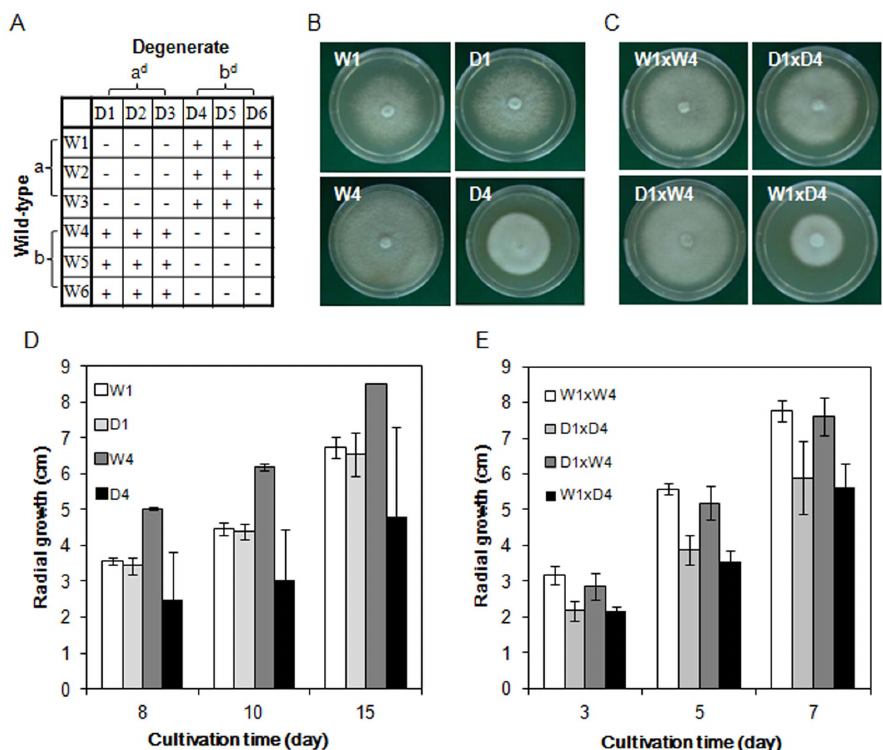
Figure 2. Growth of monokaryotic mycelia and test crosses in F.velutipes . (A) Crossing table of the monokaryons derived from the wild-type or degenerate strains. (B) Morphology of the mycelia of the degenerate monokaryons (right) and their wild-type (left) counterparts. W1 and D1 (upper panel) and W4 and D4 (lower panel) have compatible relationships. (C) Mycelial morphology of hybrids from crosses between monokaryons of wild- type and degenerate strains. The growth rates of the monokaryon (D) and hybrid test crosses (E) were determined based on the diameter of mycelia grown at 25 u C.